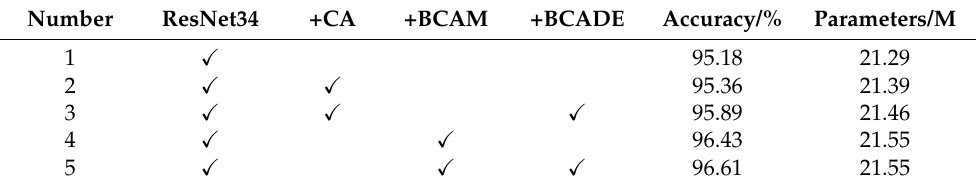
Table 3. Ablation test results of the constructed